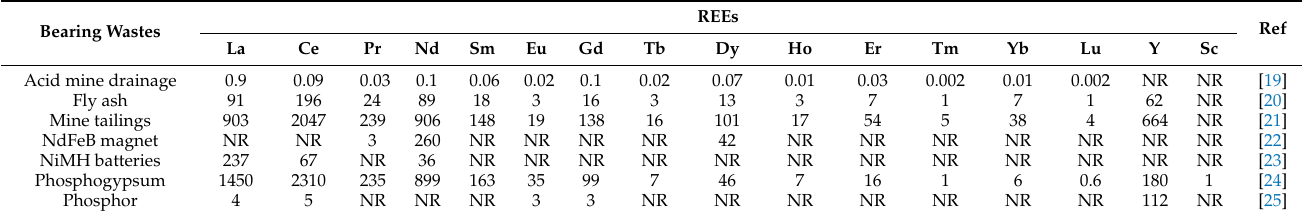
Table 1. REE content from various recycling waste streams (ppm).